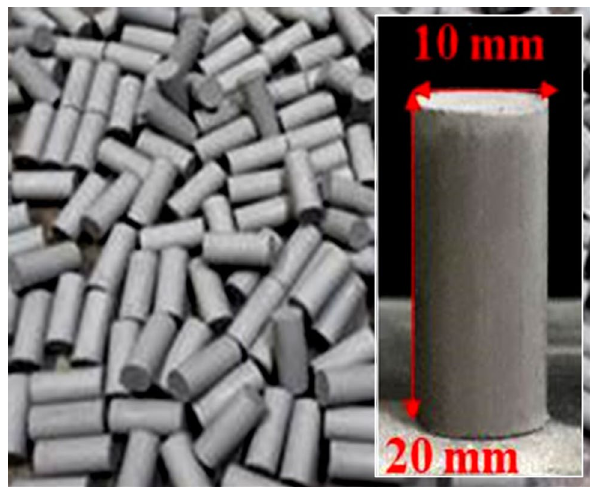
Figure 2. The CaMnO 3 rods.